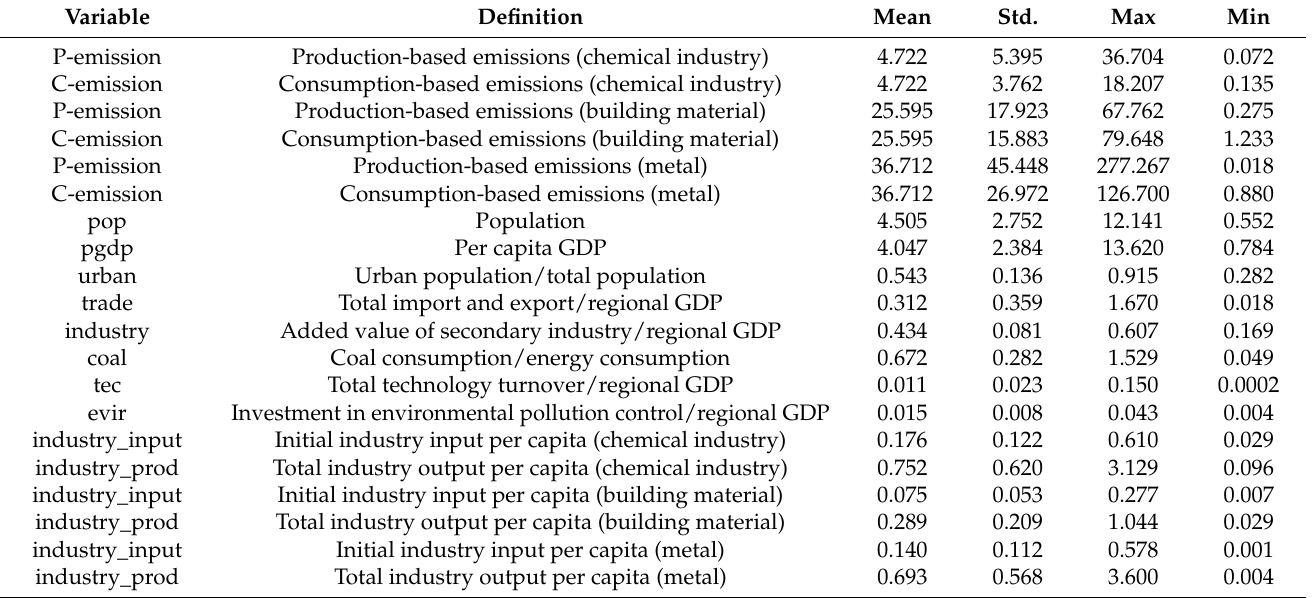
Table 1. Variable definitions and descriptive